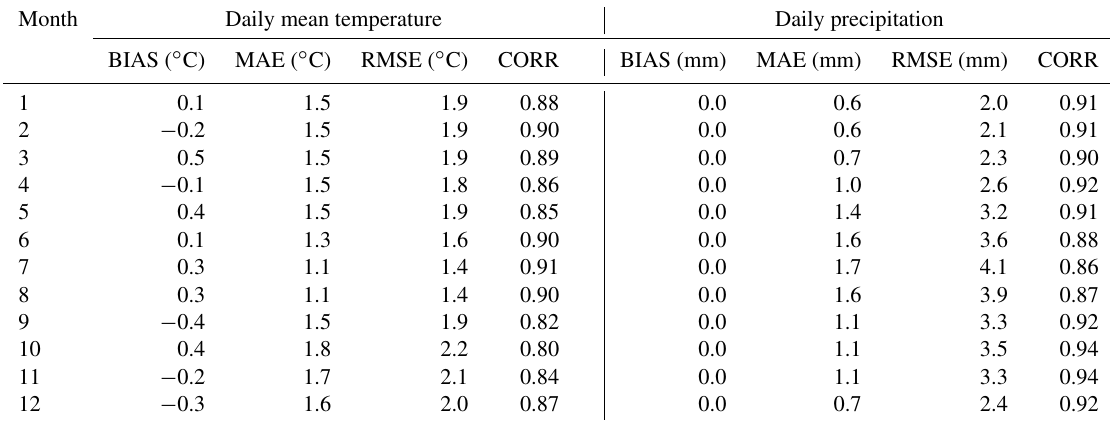
Table 1. Monthly mean leave-one-out reconstruction errors and correlation for Trentino-South Tyrol daily mean temperature and daily precipitation series over the period 1980–2018. BIAS is computed as the difference between simulations and observations.